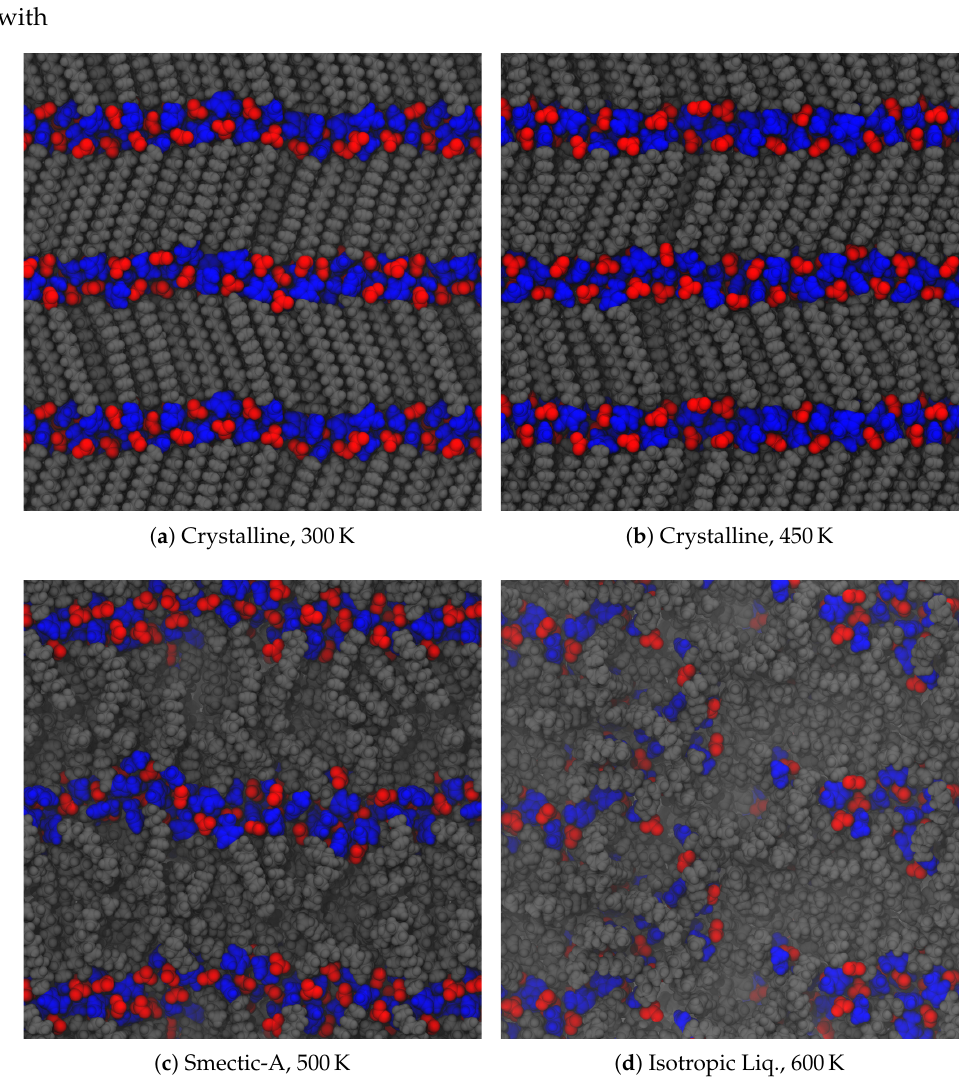
Figure 3. Observed phases in the ionic liquid crystal material, [C 16 MIm][NO 3 ]. Typical configura- tions are presented from temperatures ranging between ( a ) 300K and ( d ) 600K. The tilted layers in ( a ) are consistent with other models [4], though the alternating direction of tilt is most likely due to our simulations’ proposed initial configurations. Frustrations within the crystal are visible in ( a ), as some aliphatic tails are bent within the layer and anions exhibit irregular placement. Intermediate temperatures illustrated in ( b , c ) depict the system on either side of the crystal–smectic phase transi- tion. The isotropic liquid still exhibits segregation, but the layers have lost their long-range order, as evidenced by ( d